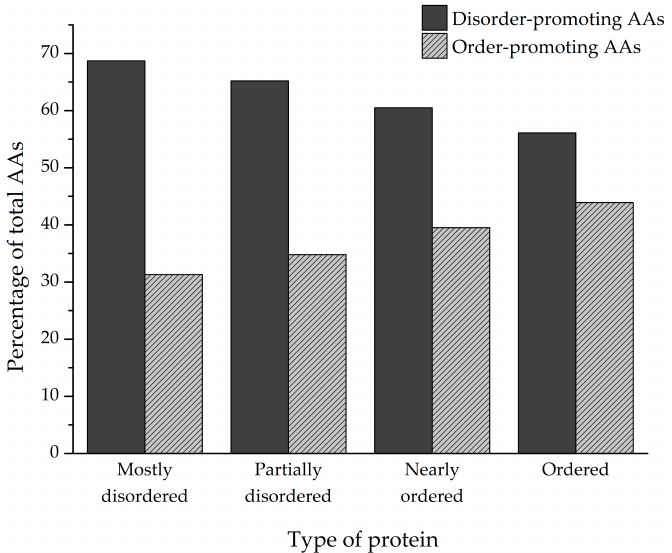
Figure 5. Ratios of disorder-promoting (P, E, S, K, Q, H, D, R, G, A) and order-promoting amino acids (T, C, N, V, L, M, I, Y, F, W) in mostly disordered (MDPs), partially disordered (PDPs), nearly ordered (NOPs), and ordered proteins